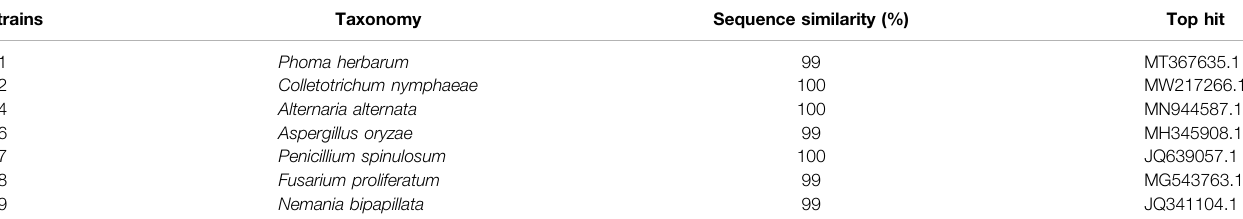
TABLE 1 | NCBI blast results of samples. Strains